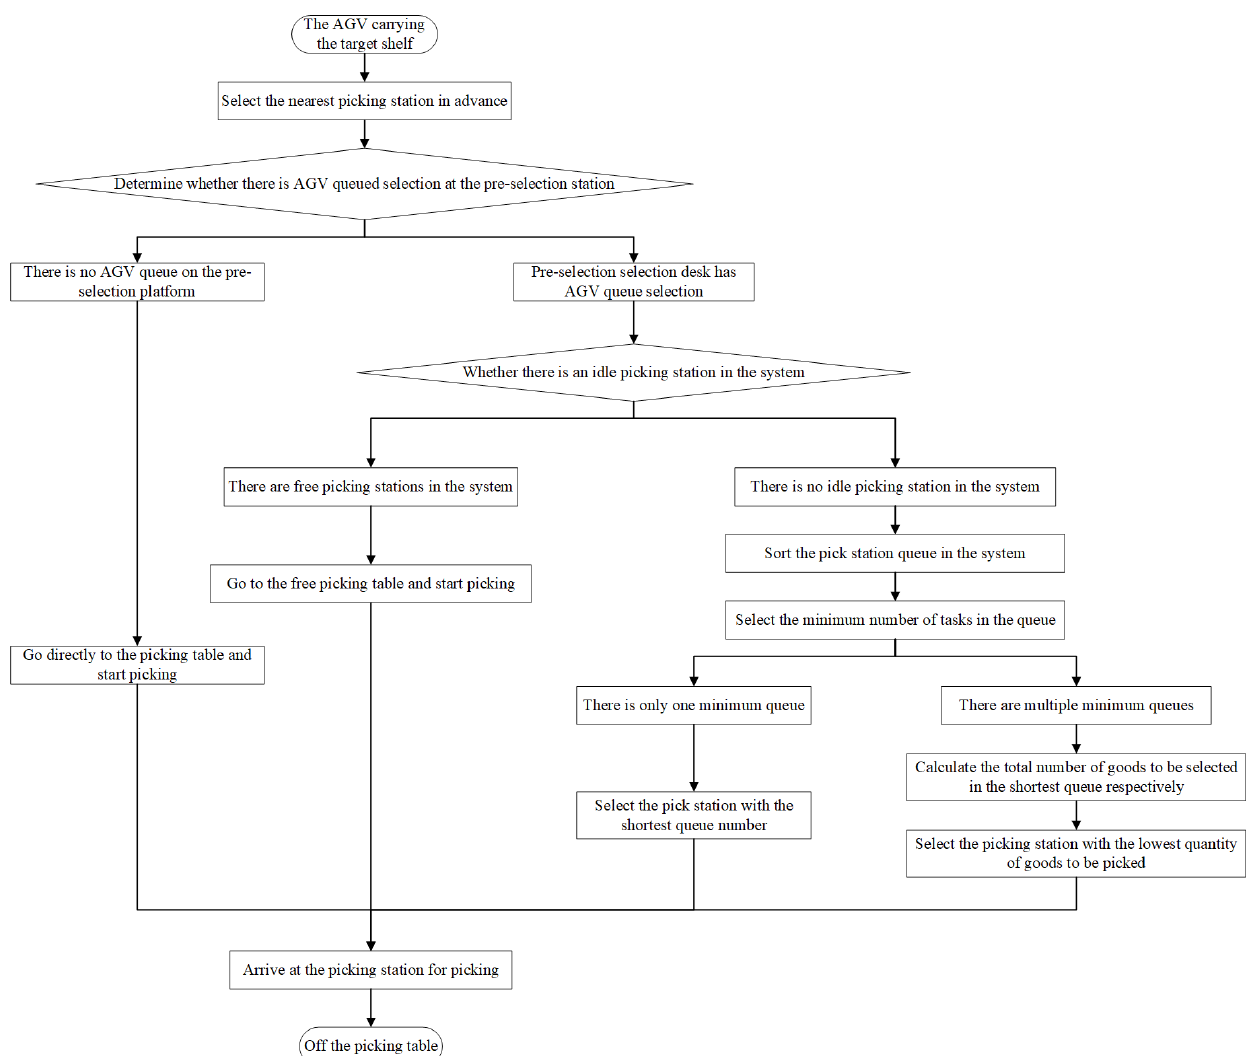
Figure 9. The dynamic optimization strategy of picking